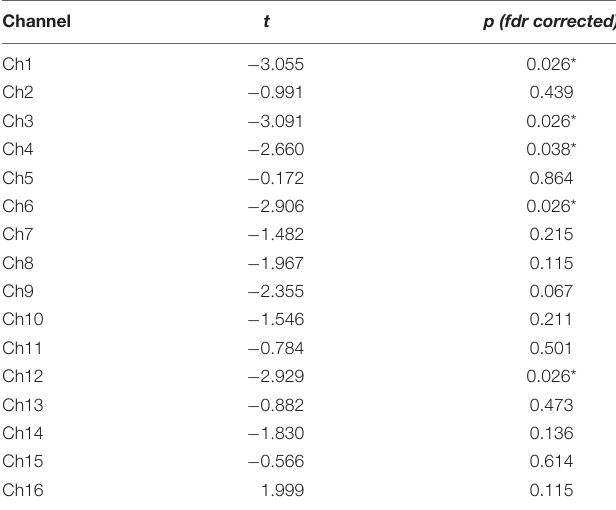
TABLE 5 | Two-sample t -test results for the comparison of brain activation patterns in each channel during emotional expression between the two participant